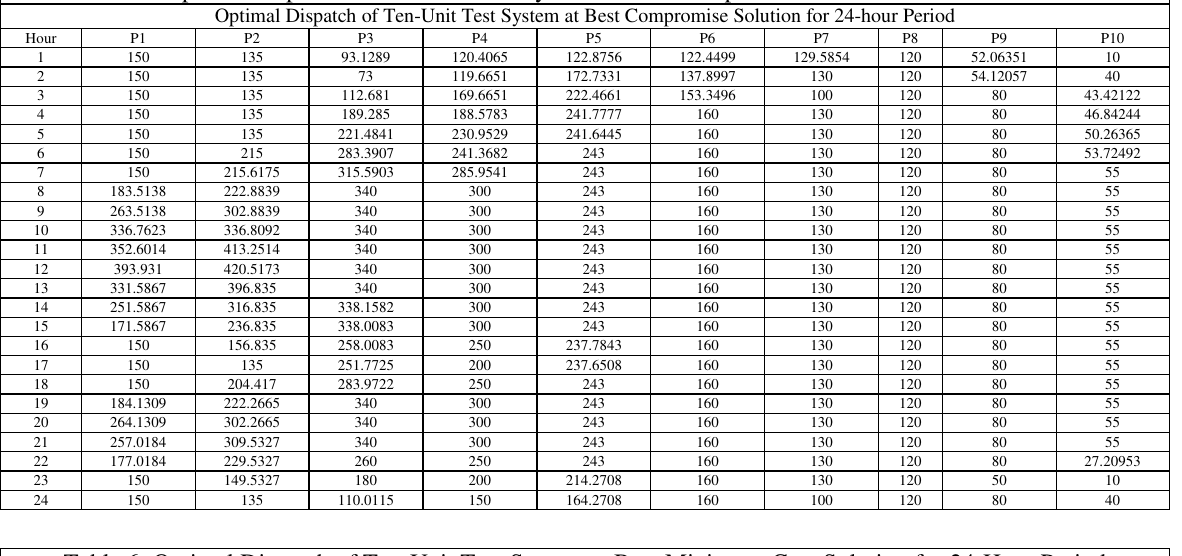
Table 5: Optimal Dispatch of Ten-Unit Test System at Best Compromise Solution for 24-Hour Period